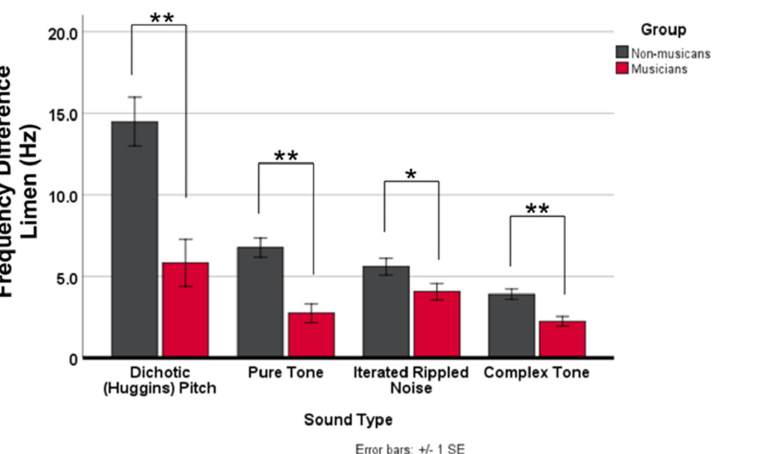
Figure 2. Bar graph shows mean DLF thresholds ( ± 1 SE). Musicians have smaller (better) pitch dis- crimination thresholds in all conditions, relative to non-musicians (* p < 0.05; ** p <